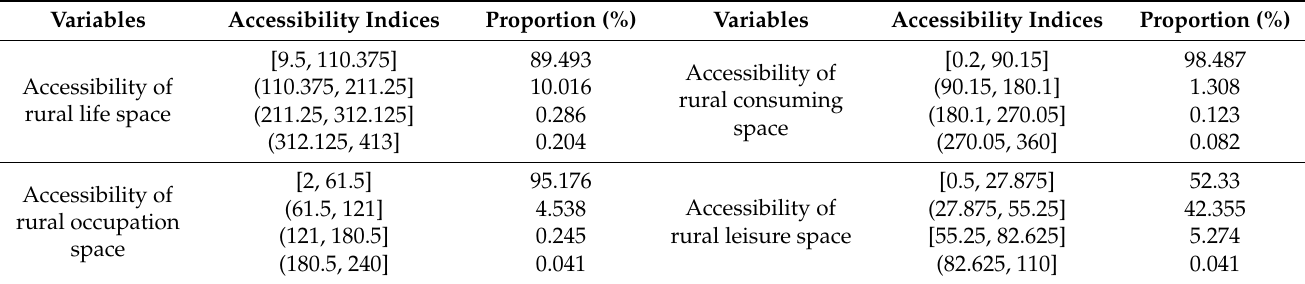
Table 3. Accessibility of rural life space in Jianghan Plain.